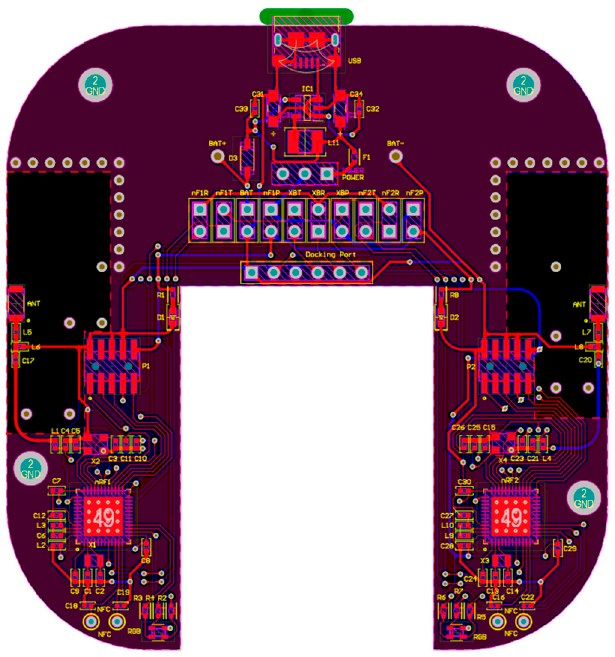
Figure 3. The structure of electrical connections of the radio tomography probe designed by CBRTI Sp. z o.o. Research and Development Center.